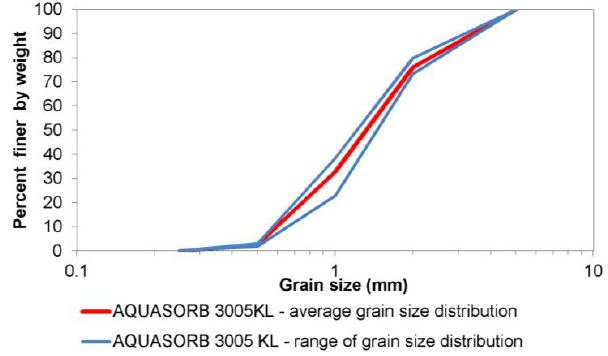
Figure 2. Grain size distribution of the tested superabsorbent polymer.